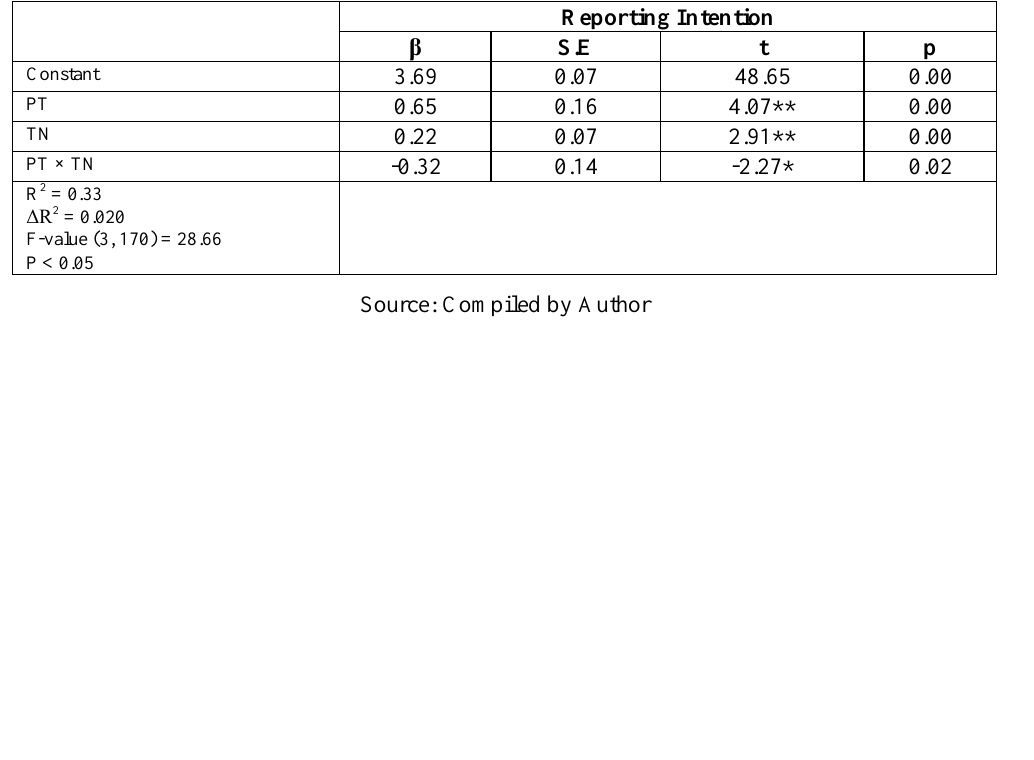
Table 3. Results of Moderating Impact of Team Norm on the Relationship